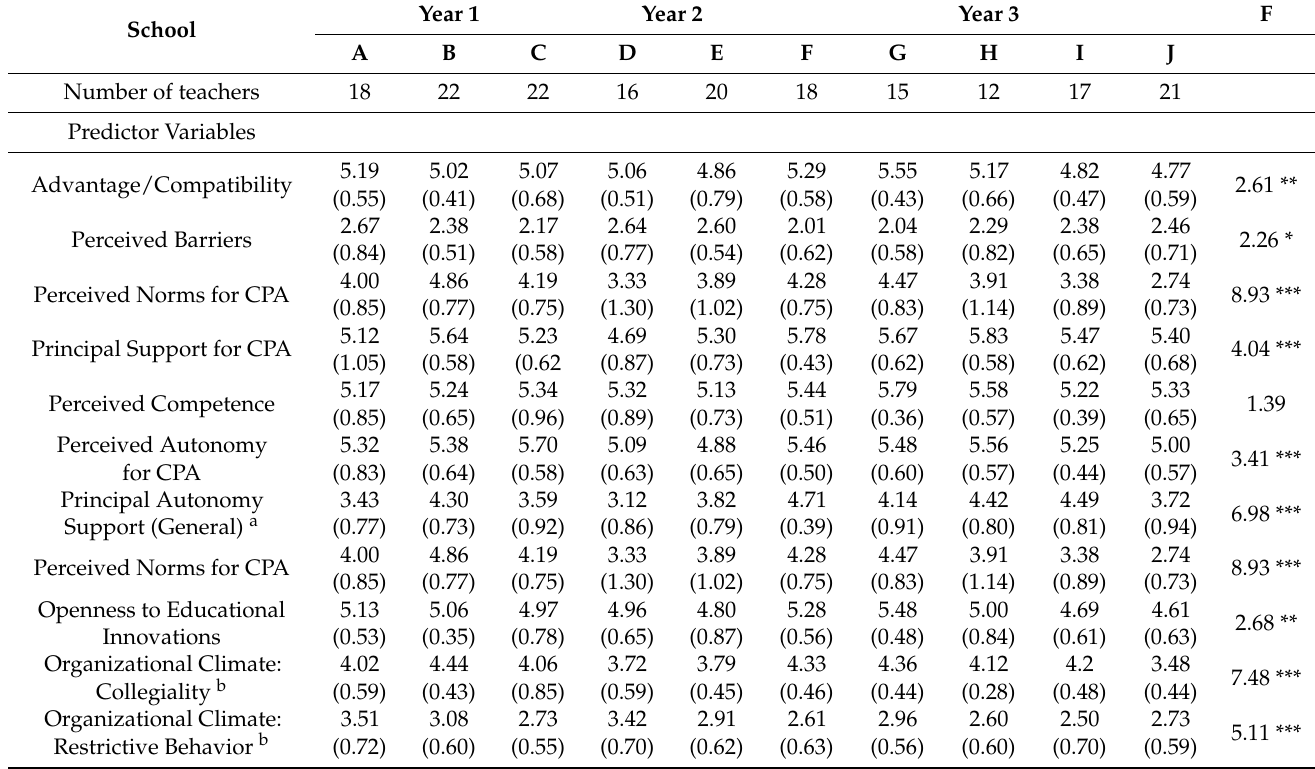
Table 3. Mean Scores and Standard Deviations for Each Construct, by